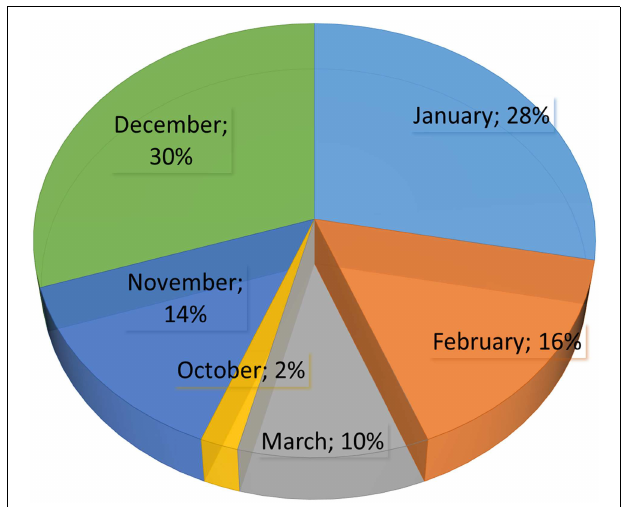
FIGURE 2 | Total region used with its regional topography. The two squares inside in the total region represent the study area and the main position of the SACZ pattern.